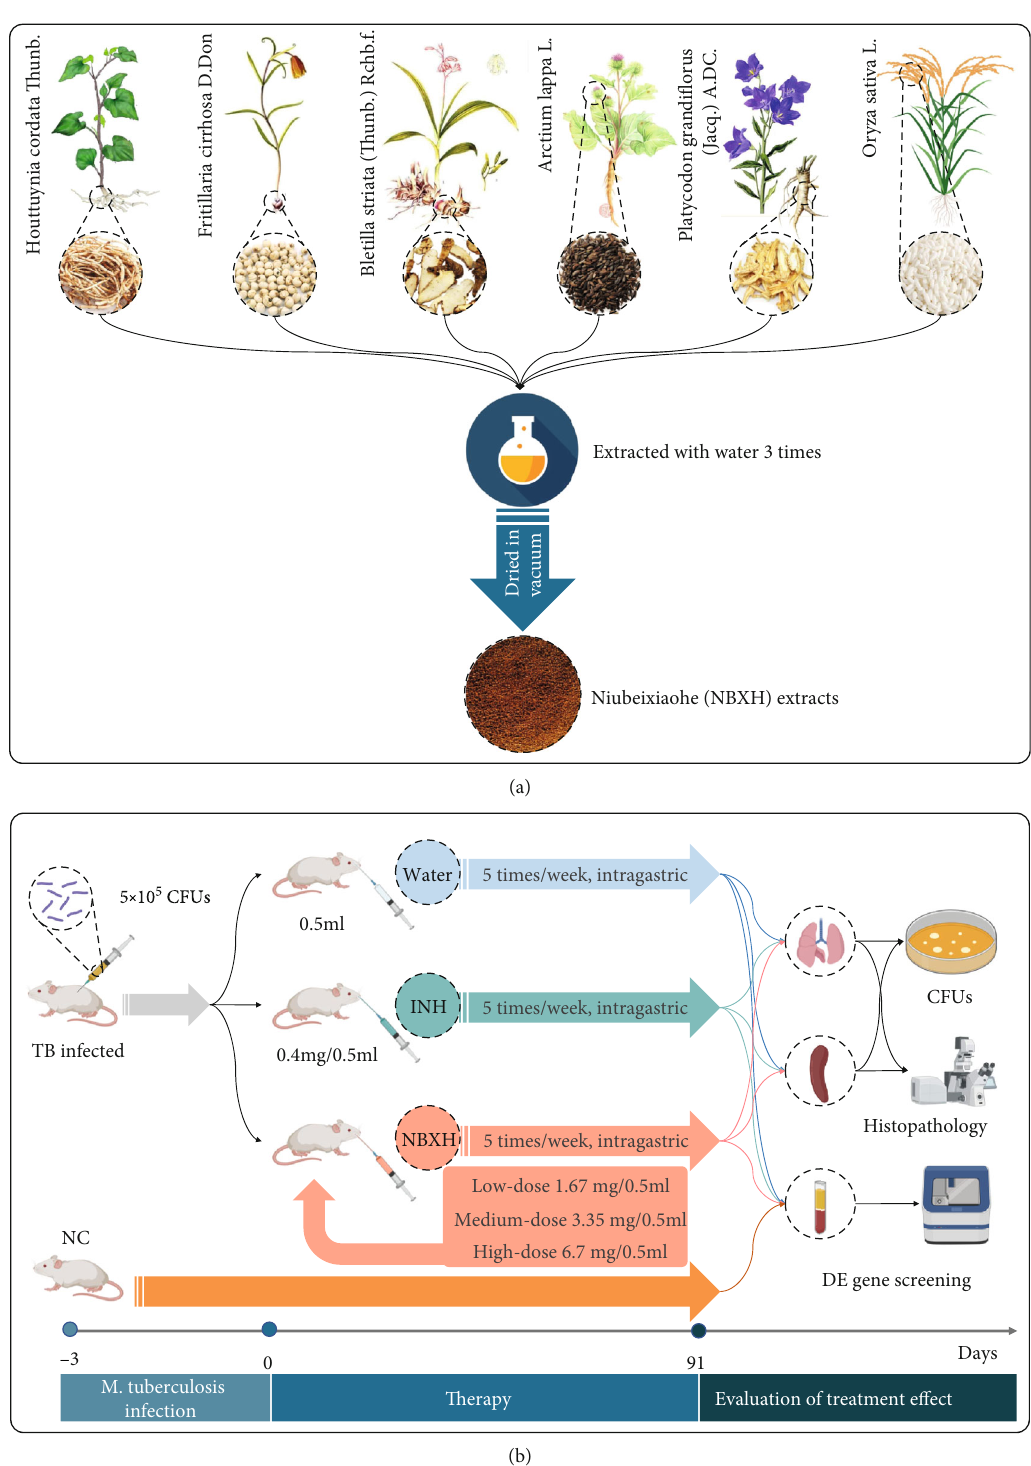
Figure 1: The elements of traditional Chinese medicine NBXH and its fl ow chart of immunotherapy in a mice model. (a) Schematic diagram of the six natural plants of NBXH. (b) Three days before immunotherapy, 53 female BALB/c mice were infected by M. tuberculosis H37Rv strain with 5 × 10 5 CFUs per mouse. Then, three mice were sacri fi ced to determine whether the infection model had been successfully constructed. The remaining mice were randomly assigned to fi ve groups and treated with water (negative control); INH (positive control); and NBXH-L, NBXH-M, or NBXH-H by intragastric administration fi ve times in one week. In addition, as a blank control, ten normal mice without any treatment were kept in the same condition. After 91 days of initial immunotherapy, mice were sacri fi ced, and their lungs, livers, spleens, and blood were collected to evaluate the e ff ect of immunotherapy or identify GE